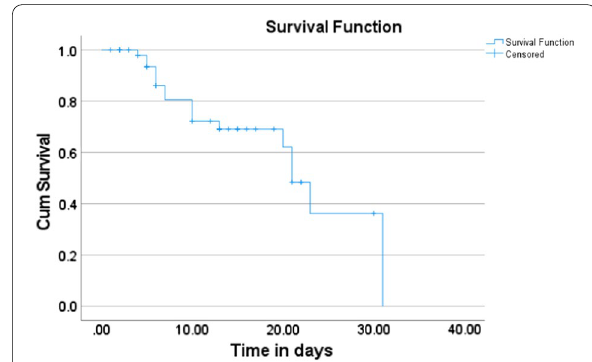
Fig. 1 Survival curve for 57 cases who are having LDH values